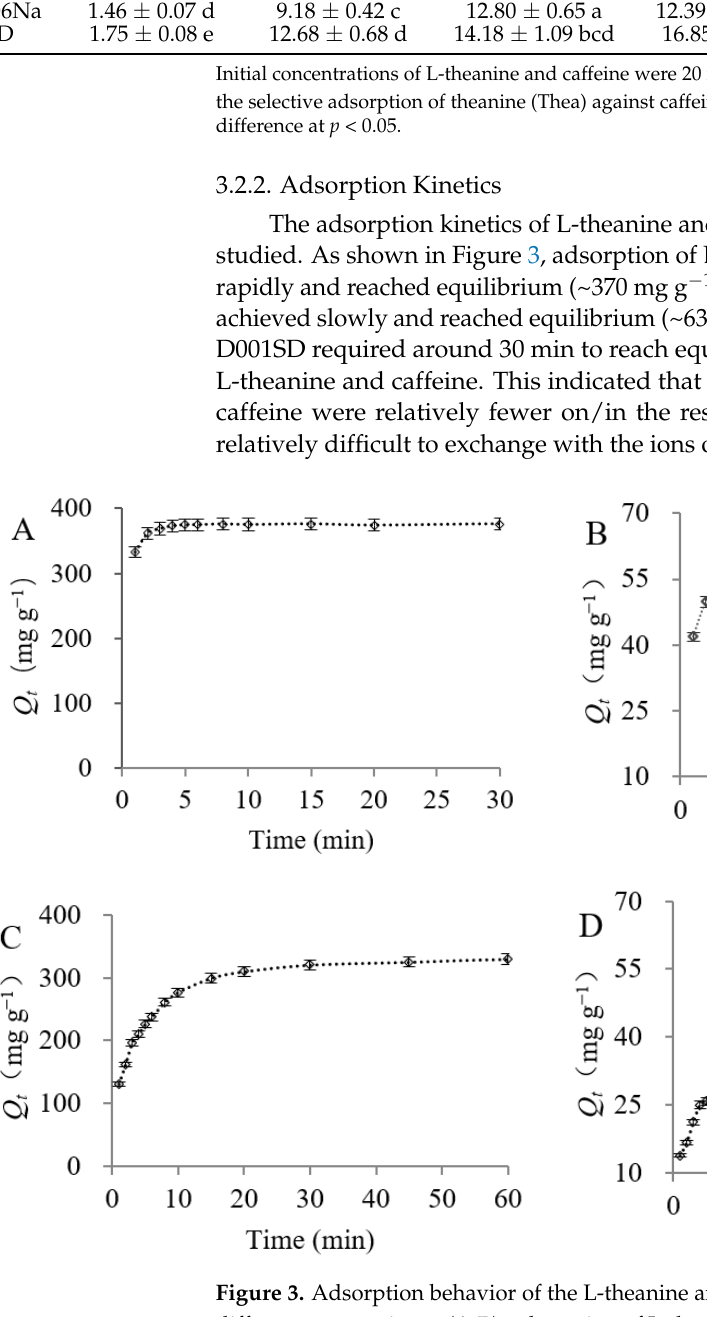
Figure 3. Adsorption behavior of the L-theanine and caffeine by the ZGSPC106Na and D001SD after different contact times. ( A , B ), adsorption of L-theanine and caffeine by ZGSPC106Na; ( C , D ), adsorption of L-theanine and caffeine by D001SD.